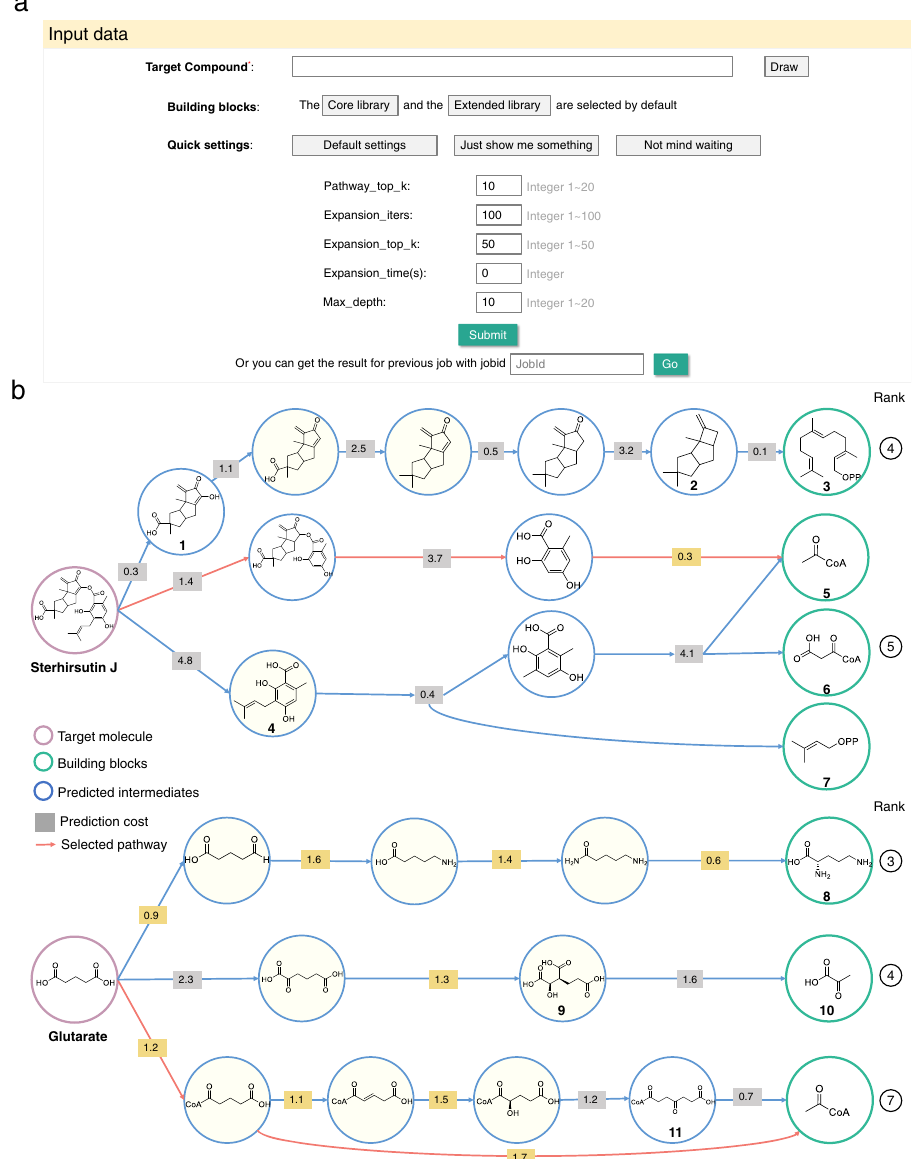
Fig. 3 The interface and output of BioNavi-NP webserver. a The input interface and of BioNavi-NP webserver. b The selected pathways of two examples (sterhirsutin J and glutarate) predicted by BioNavi-NP. Herein the outputs are redrawn to be clear (the raw output provided in Supplementary Figs. 27 and 33), and some candidate pathways with the order of ranks attached at the end, and the top 1 pathway is colored in red. The known intermediates and reactions are highlighted in yellow. There is also an option to select which pathway to be highlighted or shown. The cost of each reaction step is re fl ected by the con fi dence score (smaller prediction cost means higher reaction probability, see Methods), and the total cost of the pathway is used to rank the network by